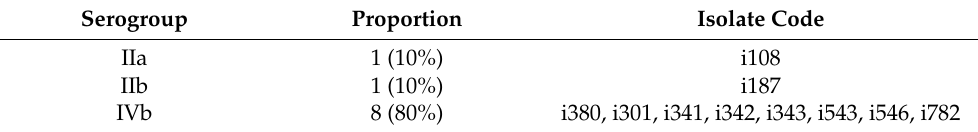
Table 4. Description of the obtained serogroups among L. monocytogenes confirmed isolates ( n = 10). Serogroup Proportion Isolate Code IIa 1 (10%) i108 IIb 1 (10%) i187 IVb 8